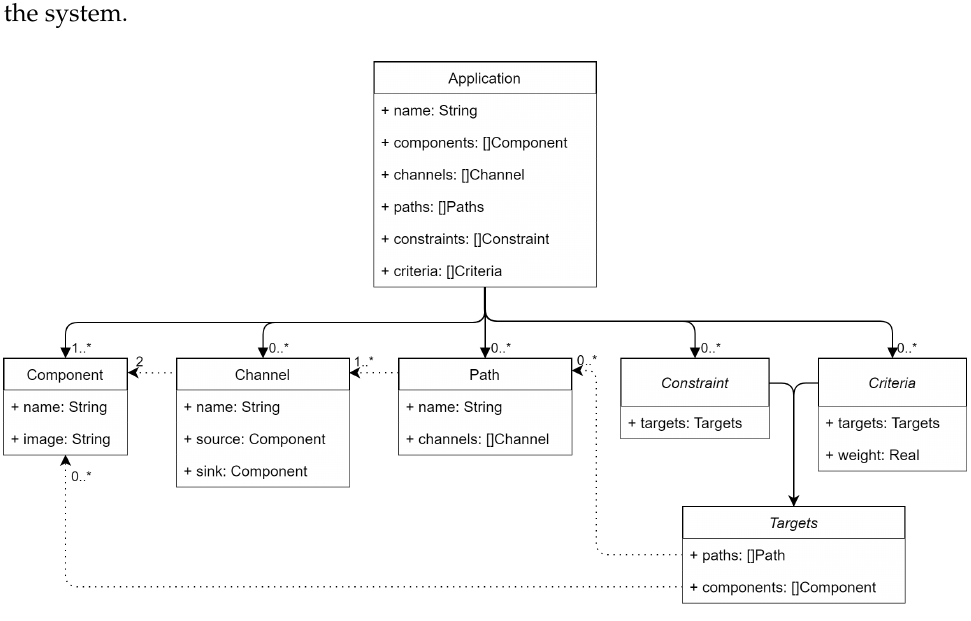
Figure 3. Workload